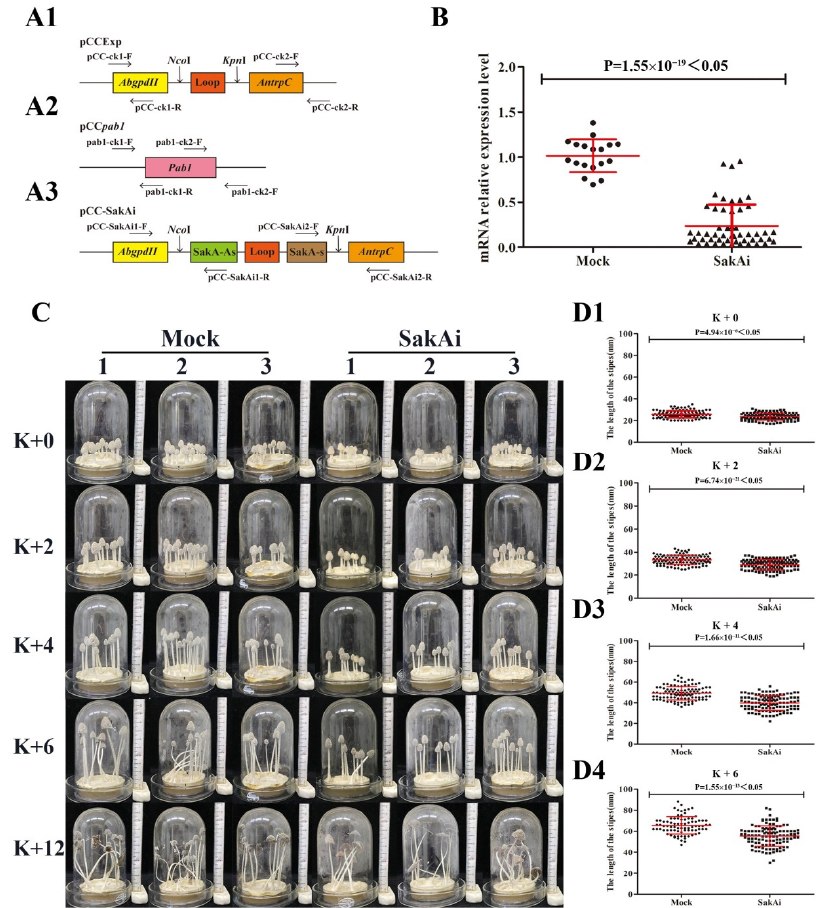
Figure 2. Construction and phenotypes of CcSakA gene-silenced strains. ( A ) Schematic representation of plasmids pCcExp ( A1 ), pCc pab-1 ( A2 ), and pCC-SakAi ( A3 ). The arrows below the plasmids indicate the primers for genomic PCR. ( B ) The relative mRNA expression level of sakA in mock transformants (circle) and SakAi transformants (triangle). ( C ) Growing fruiting bodies of the three representatives of the mock transformants and SakAi transformants at different time points. ( D ) The stipe lengths of the fruiting bodies of four mock transformants (circle, n = 109 fruiting bodies) and eight SakAi transformants (square, n = 124 fruiting bodies) with at least three repeats of each transformant at K + 0 ( D1 ), K + 2 ( D2 ), K + 4 ( D3 ), and K + 6 ( D4 ). 3.3. Effects of Expression of a Phosphomimicking Mutant CcSakA on the Stipe Elongation of C. cinerea The activation of CcSakA, which is the MAPK in the HOG pathway, was dependent on its phosphorylation on the threonine residue and tyrosine residue in the conserved TGY phosphorylation site [39,46]. To further analyze the role of CcSakA in the mycelium growth and stipe elongation of C. cinerea , the phosphomimicking mutant of CcSakA bearing a T170E/Y172D substitution within the TGY dual phosphorylation motif was constructed [47]. The plasmid pCC-SakA T170E+Y172D (Figure 3(A3)) for the expression of the phosphomimicking mutant of the CcSakA mutant was constructed and cotransformed